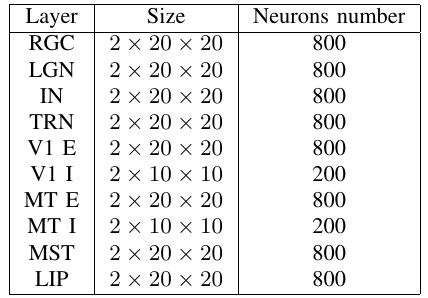
V ISUAL PERCEPTION AND DECISION MAKING MODEL DIMENSIONALITY